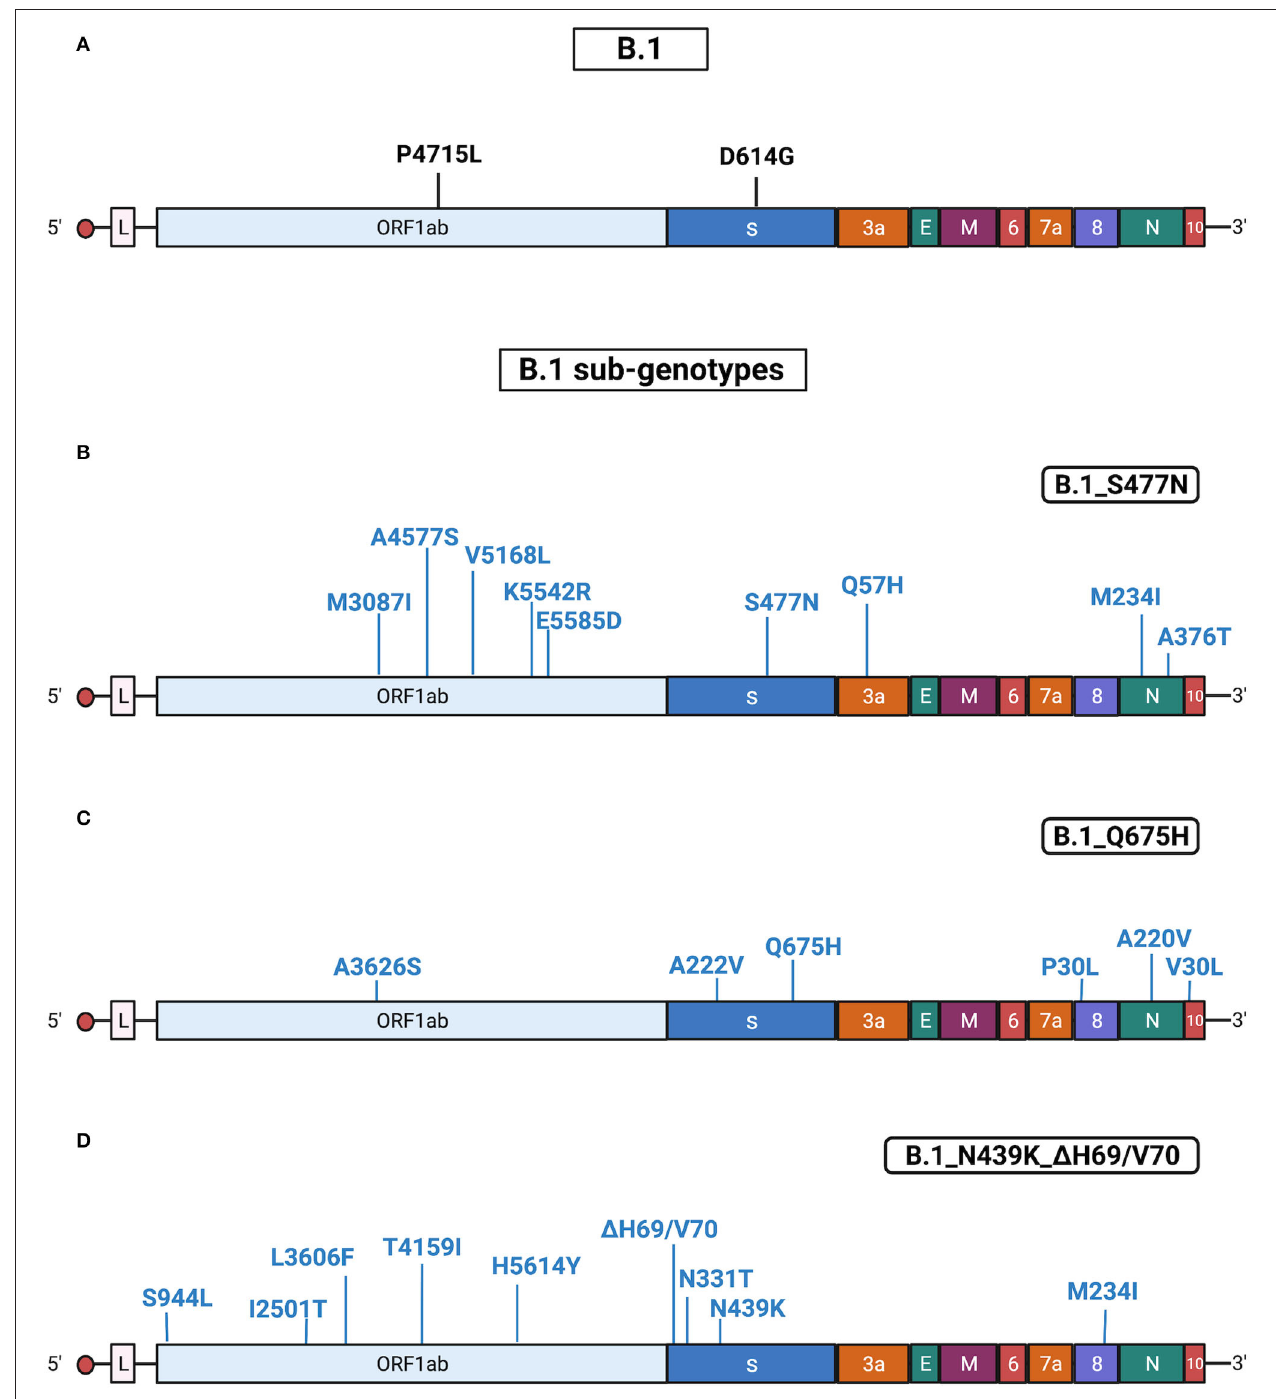
FIGURE 3 | Substitutions in B.1 isolates. The figure shows the substitutions identified in the B.1 isolates by NGS. Color code: black, substitutions common to all B.1 isolates; blue, substitutions specific for the different B.1 sub-genotypes. (A) Substitutions common to all B.1 isolates. (B) Substitutions identified in all B.1 isolates characterized by the presence of S477N (sub-genotype B.1_S477N). (C) Substitutions identified in all B.1 isolates characterized by the presence of Q675H (sub-genotype B.1_Q675H). (D) Substitutions identified in all the B.1 isolates characterized by the presence of N439K/ 1 H69- 1 V70 (sub-genotype B.1_N439K/ 1 H69- 1 V70). Gene abbreviations: ORF, open reading frame; S, Spike; E, envelope; M, membrane; N, nucleocapsid. Adapted from “Genome Organization of SARS-CoV” by BioRender.com (2022). Retrieved from